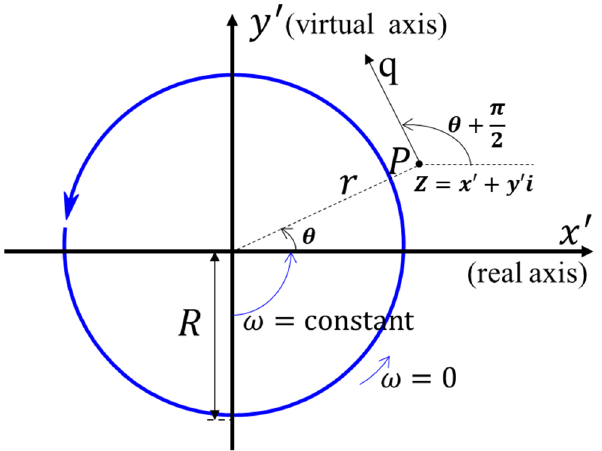
where r denotes the distance between point P and the center of the image vortex. Assume sume that the angle between the direction of flow velocity at point that the angle between the direction of flow velocity at point P and the real axis of the the complex plane is complex plane is θ + π /2, and then the velocity vector at point P can be described as in Equation (2) represents the velocity component in the horizontal direction, and in which U represents the velocity component in the horizontal direction, and V stands for for the vertical velocity component. the vertical velocity component.